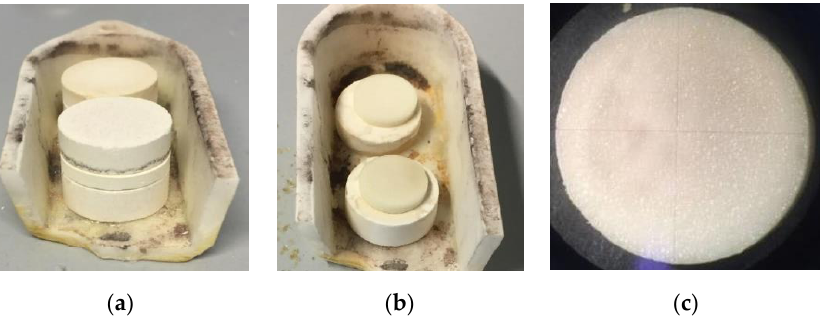
Figure 1. Pellets of Ga40-LLZO before ( a ) and after ( b ) the final sintering step at 1230 °C, the top and bottom pellets are buffer pellets of the same composition. ( c ) A pellet of Ga40-LLZO under a stereo-loupe; note, the diameter of the pellet is 8 mm.